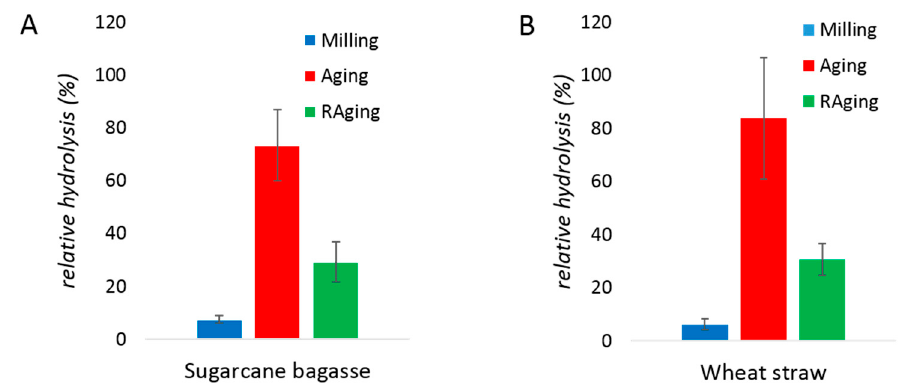
Figure 5. Enzymatic hydrolysis of sugarcane bagasse ( A ) and wheat straw ( B ) by xylanase after 30 min of milling (blue), 30 min of milling and 72 h of aging at 55 ◦ C (red), or 12 h of RAging via 12 cycles of 5 min milling + 55 min aging (green) conditions. The reactions were performed at 0.13% ( w / w ) protein loading on 400 mg of substrate, with 600 µ L of water ( η = 1 µ L / mg). Reactions were performed in triplicates and the error bar is the standard deviation.